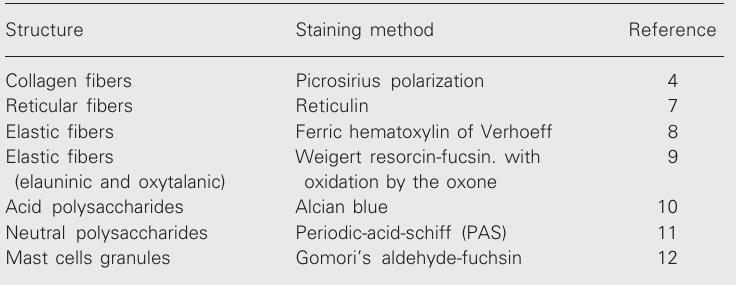
Table 1. Histochemical methods used to identify structures in the skin of hr USP mutants and BALB/c